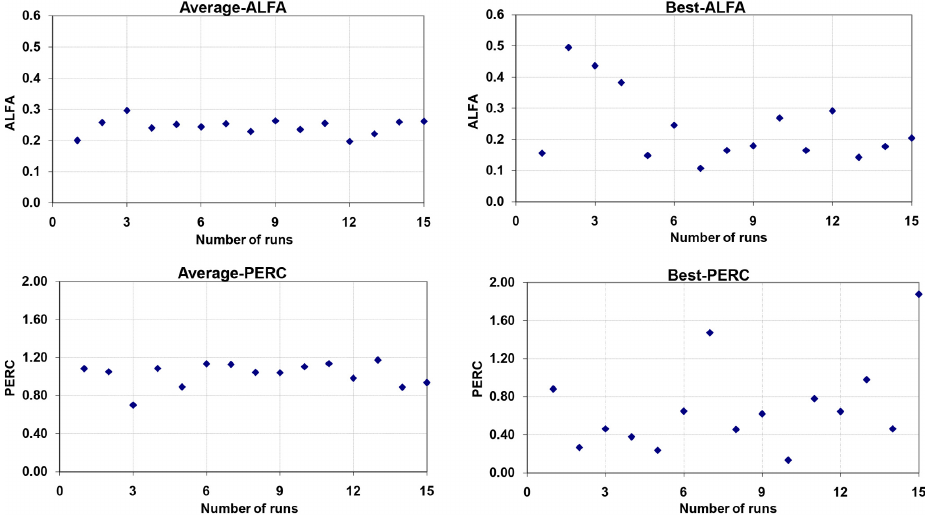
Fig. 3. Left hand side shows the average parameter values the 25 best performing parameter sets for ALFA and PERC for each MCS run of 60000 runs each. The right hand side shows single best parameter values.